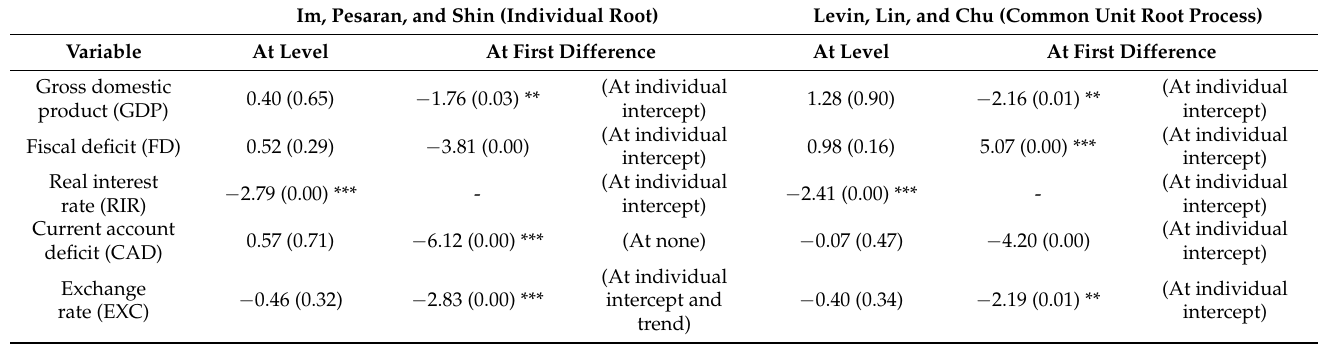
Table 7. Findings of panel unit root testing for higher-income economies (HMIE).